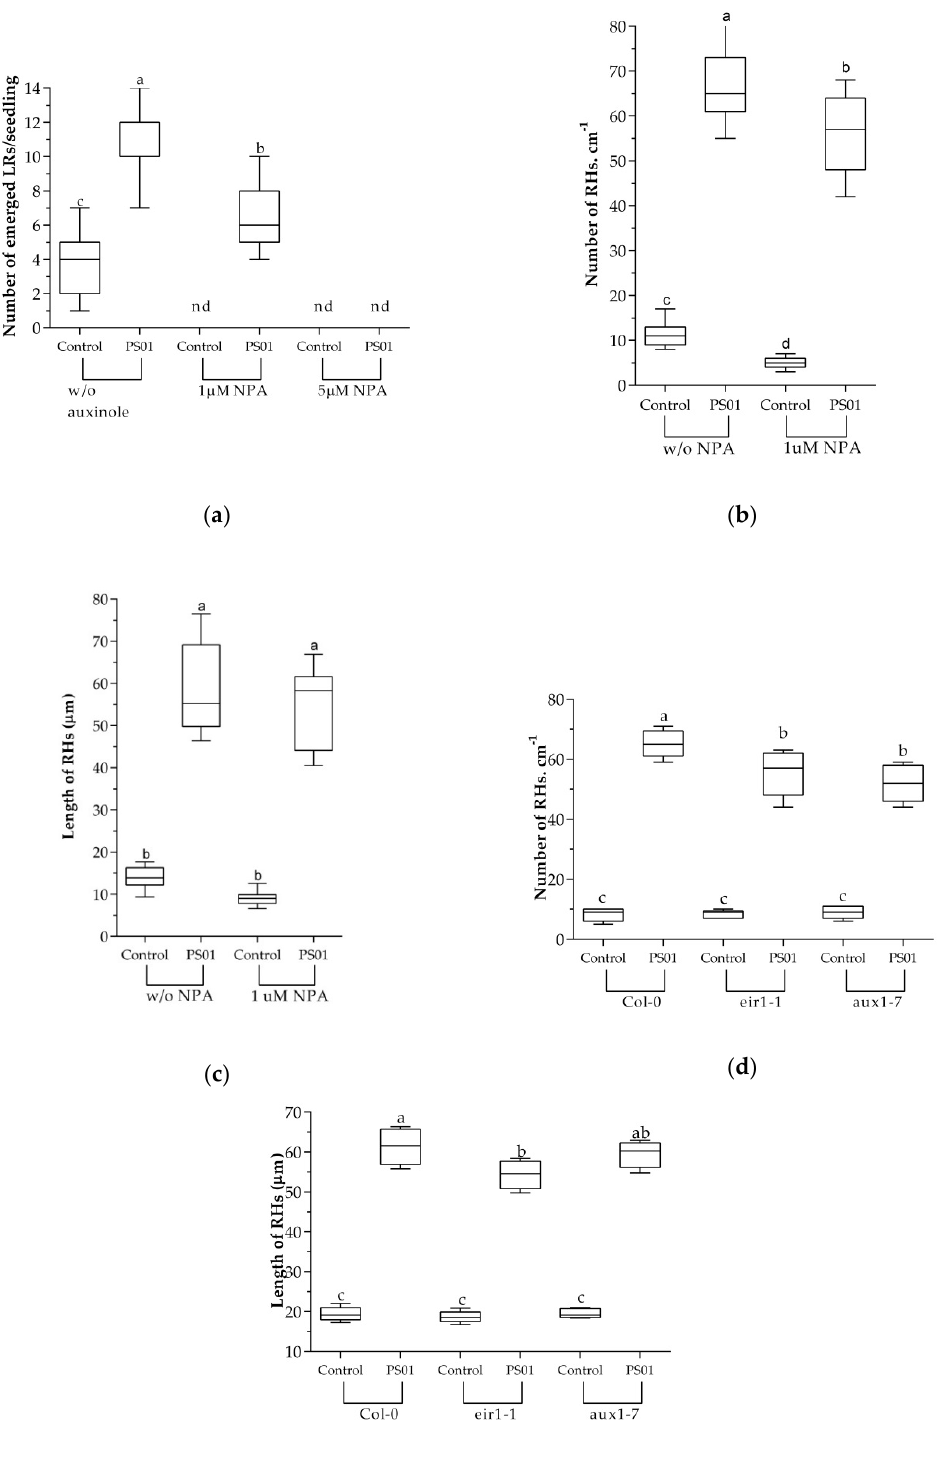
Figure 10. Influence of auxin transport on PS01-mediated RSA alteration in Arabidopsis . Effects of the polar auxin transport inhibitor (NPA) on ( a ) PS01-induced LR formation; ( b ) RH density; and ( c ) RH length. Assessment of ( d ) RH density and ( e ) RH length under control and PS01-induced conditions in wild-type roots (Col-0) and roots of auxin transport mutants ( eir1-1 and aux1-7 ) after 8 d of co-cultivation. Data are depicted as boxplots representing the range of values, the exclusive median. n.d, not detected.